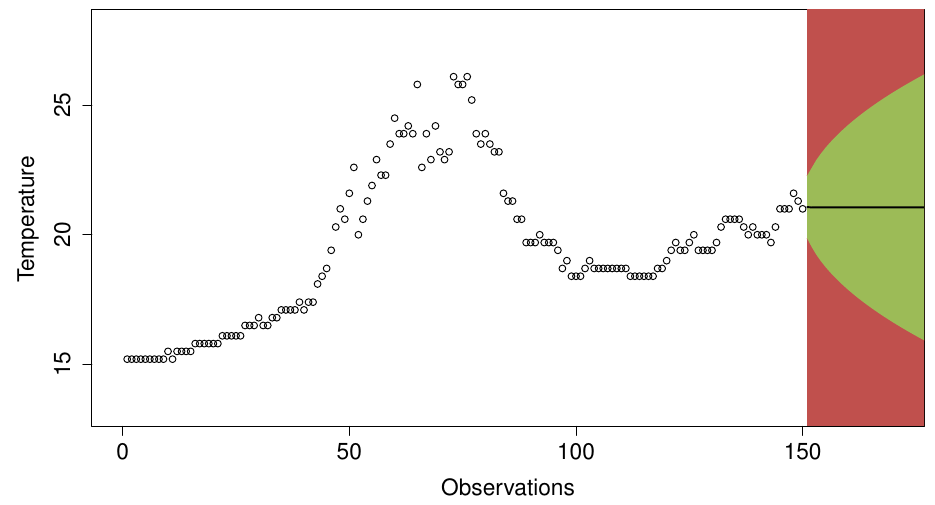
Figure 7. Predictions made for the 150th value. The green and red areas cover the zones where the next observation would be considered as normal or outlier